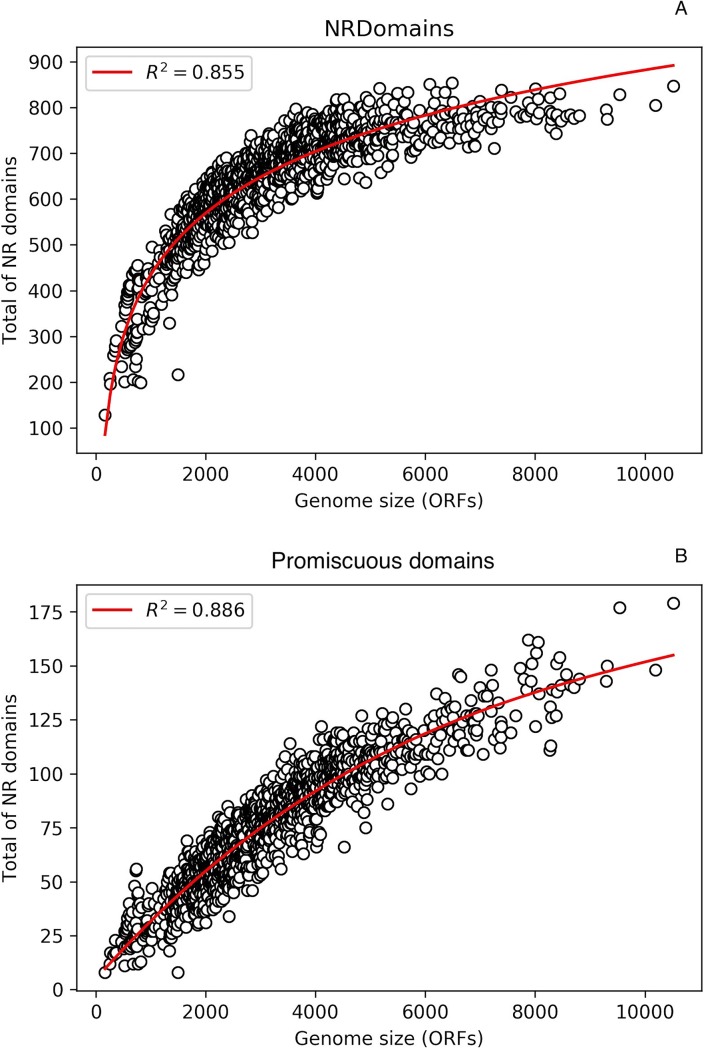
The total number of non-redundant domains follows a logarithmic distribution (A), whereas promiscuous domains follow a polynomial distribution (B). On the X-axis is the genome size (in ORFs), and on the Y-axis is the total number non-redundant (NR) domains identified. A non-linear least squared to fit the dataset was used.